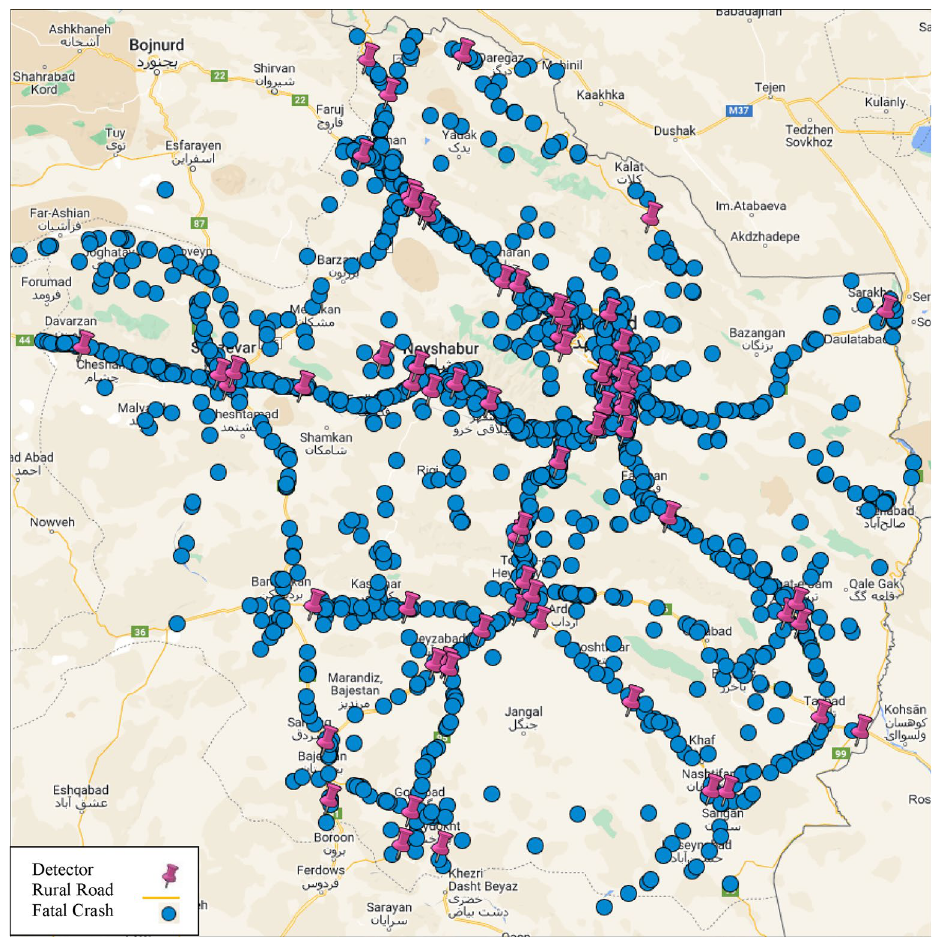
Figure 2. The distribution of crashes and detectors on rural highway network of Khorasan Razavi Province during 2014 to 2020 [Maps Data: ©2022